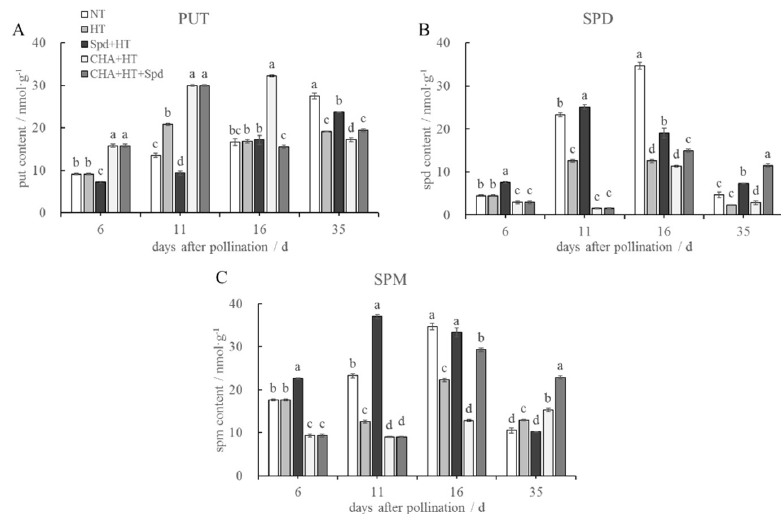
Figure 5. Effects of exogenous Spd and CHA on endogenous ( A ) Put, ( B ) Spd, and ( C ) Spm content of rice seeds at different developmental stages under high temperature (40 °C, 5 days). The bars mean standard deviation and different letters indicate significant differences between treatments at the same developmental stage (α = 0.05, LSD). The treatment methods were the same as those in the Figure 1 notes. Figure 1